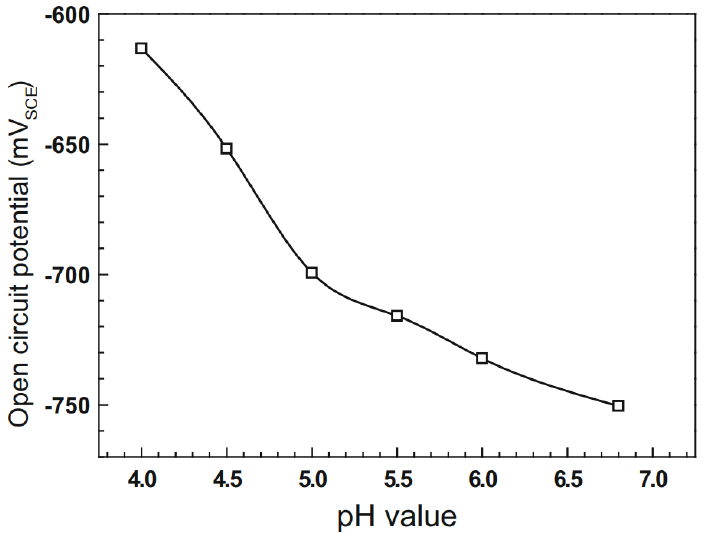
Figure 13. Variations of open circuit potential of the X70 samples in the different pH NS4 solutions [68]. Reprinted with permission from [68], 2015, Springer nature.